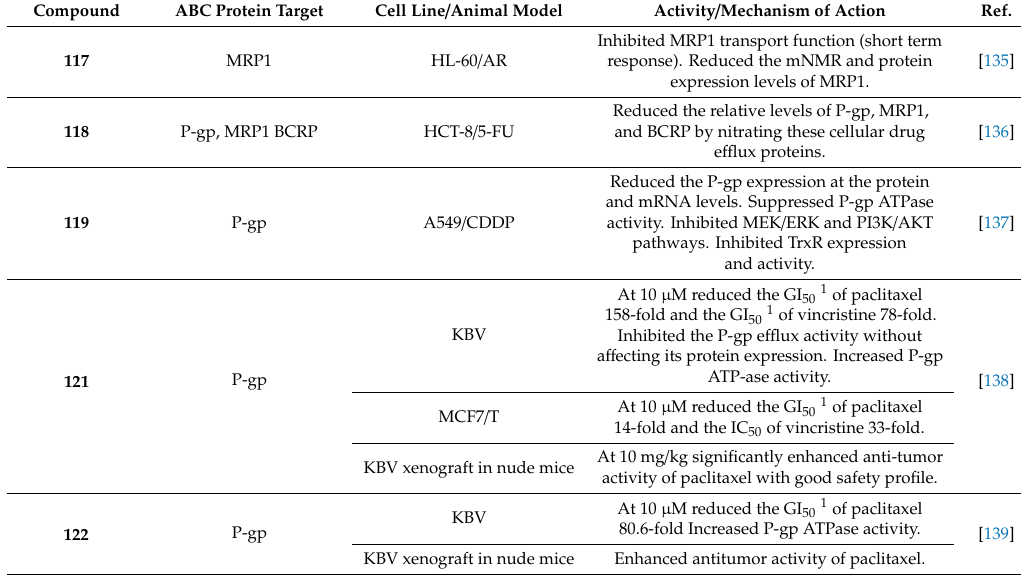
Figure 14. Triterpenoid nitrogen-containing derivatives 115 – 124. Table 14. MDR reversal properties of oleanane-type triterpene derivatives 117 – 119, 121 and 122.